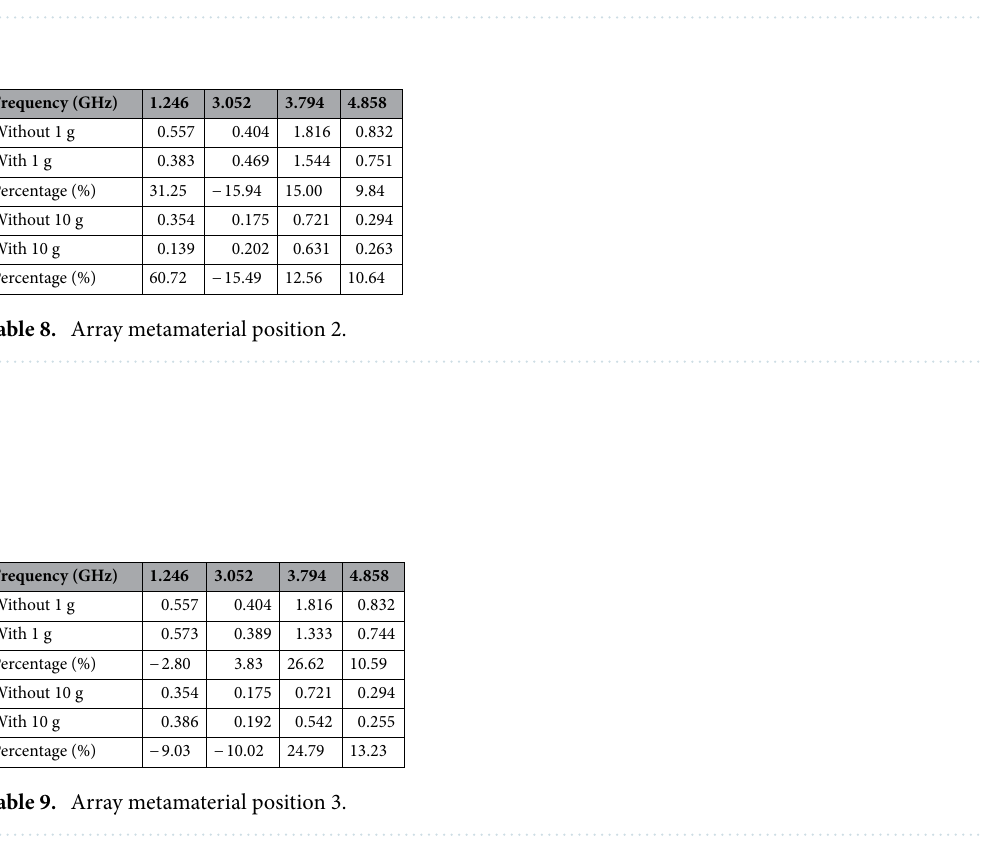
Table 7. Array metamaterial position 1.